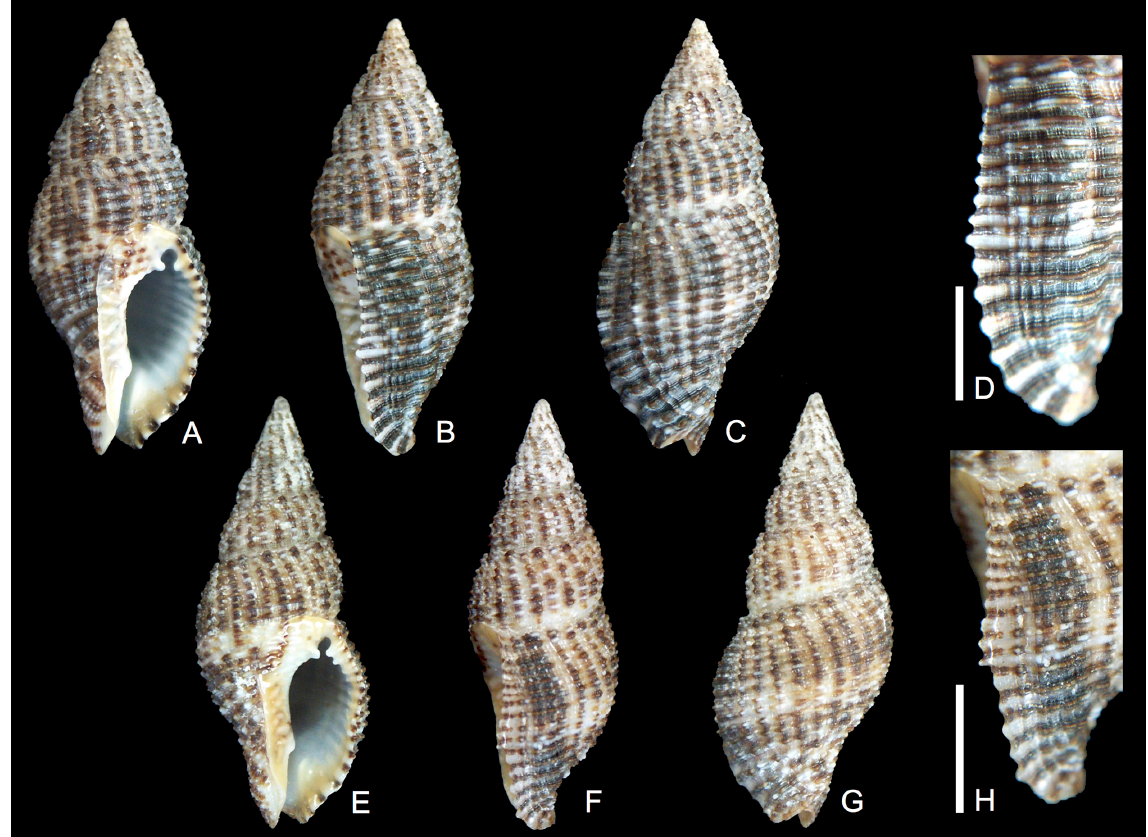
Fig. 3. Sinetectua cinis (Reeve, 1846) gen. et comb. nov. A–D . Specimen from Galápagos, Isla Baltra, depth 3–4 m, 31.0 mm long (KF 2123). E–H . Specimen from Costa Rica, Cocos Island, Dos Amigos, depth 25–30 m, 29.3 mm long (KF 1013). Scale bars: 5.0